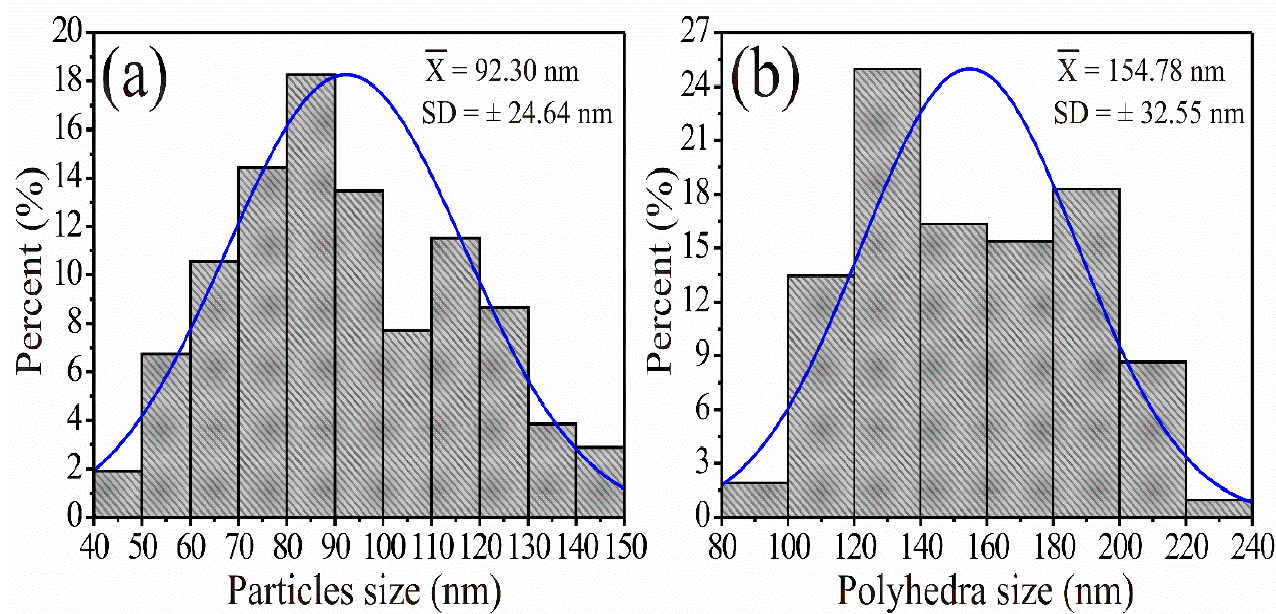
Figure 7. Morphologies’ distribution of the NiSb 2 O 6 powders calcined at 900 °C: ( a ) particle size, ( b ) size of the polyhedron- type morphologies.